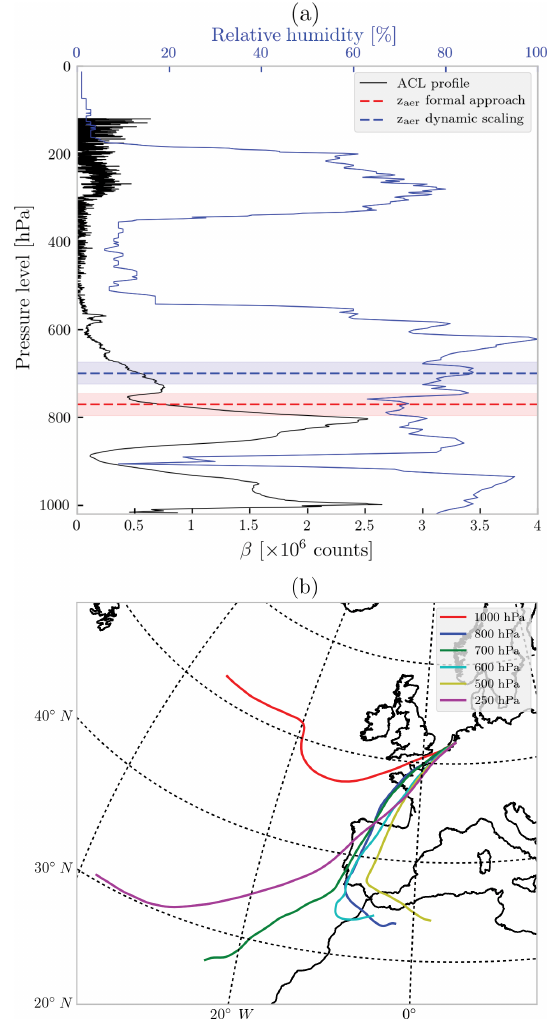
Figure 8. (a) Radiosonde profile of relative humidity (blue), plot- ted alongside an averaged raw attenuated backscatter profile (black) from the ceilometer at De Bilt, the Netherlands. Both profiles are approximately around 13:00UTC. The red and blue dashed lines represent retrieved aerosol layer height using the formal ap- proach and the dynamic scaling method, respectively. The red- and blue-shaded boxes represent the aerosol layer from the respective retrieval methods. (b) Back trajectories calculated for 17 Octo- ber 2017 at 13:00UTC with the end point at De Bilt, and the sources going back to 3